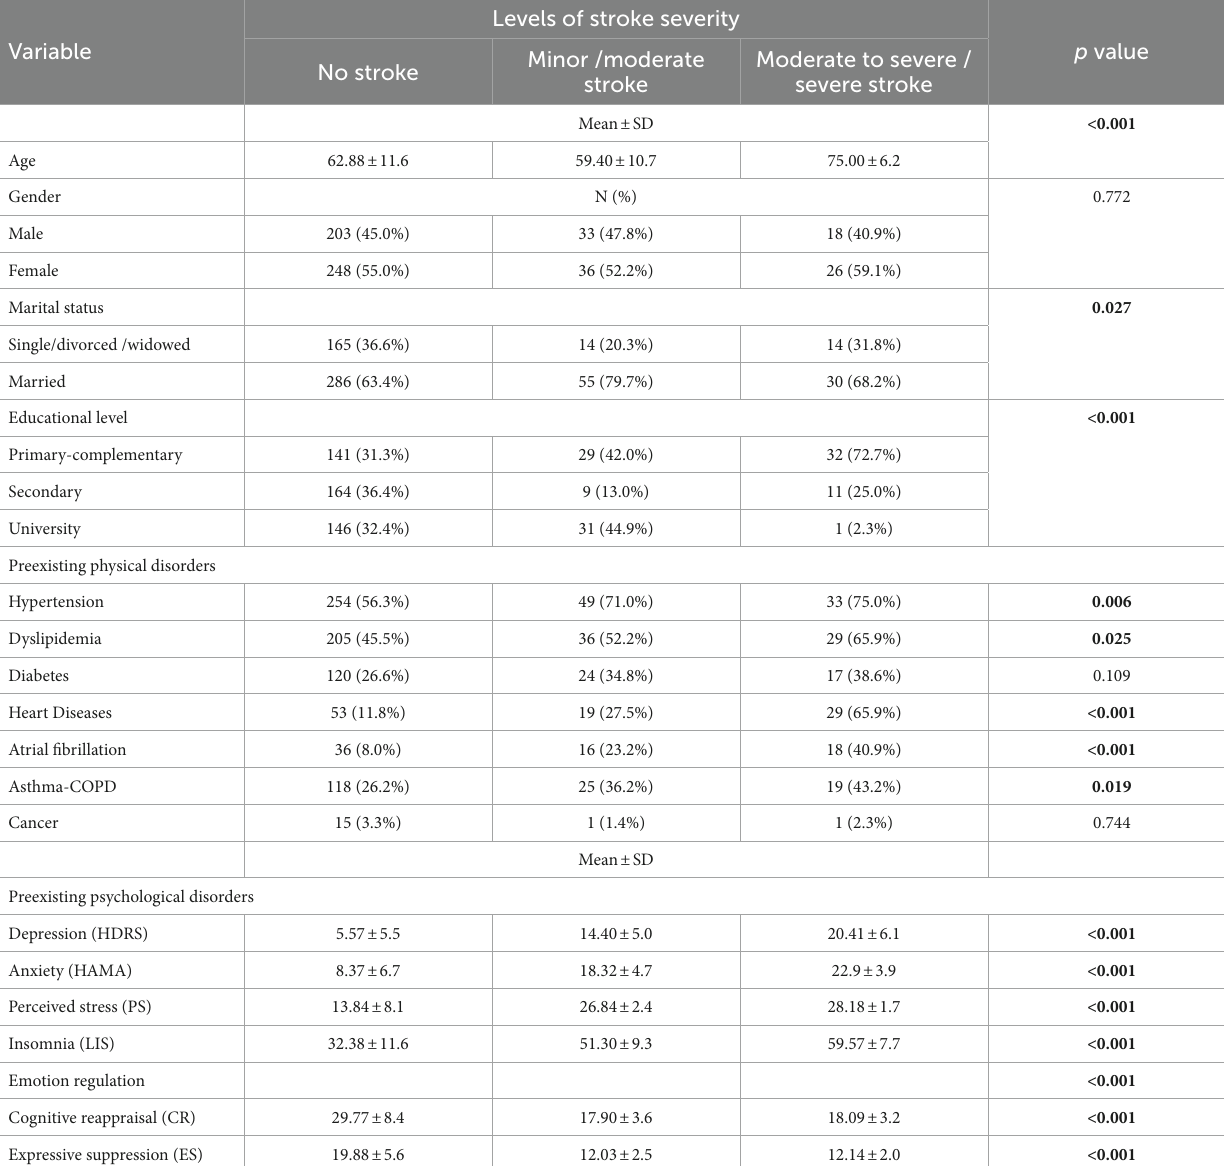
TABLE 5 Bivariate analysis of variables associated with the levels of stroke